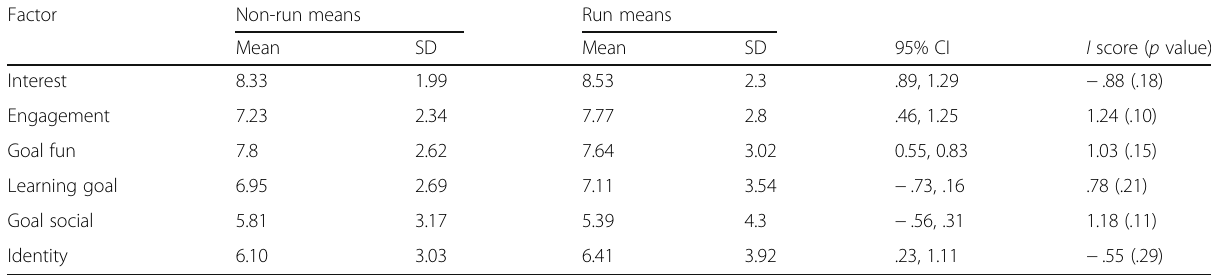
Table 5 Paired t test results comparing self-report and run data